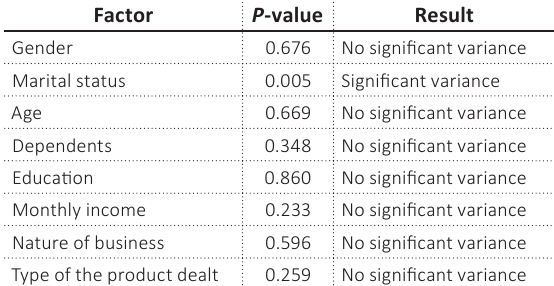
Table 2. Variances to financial